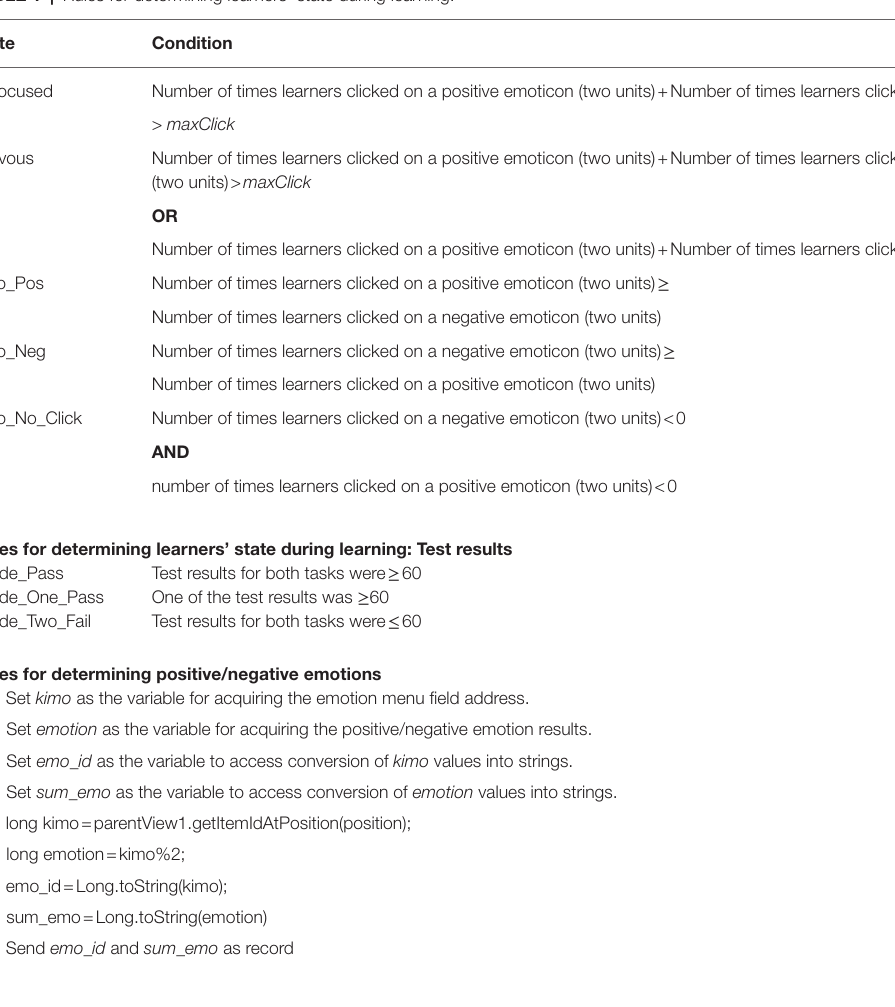
TABLE 1 | Rules for determining learners’ state during learning.